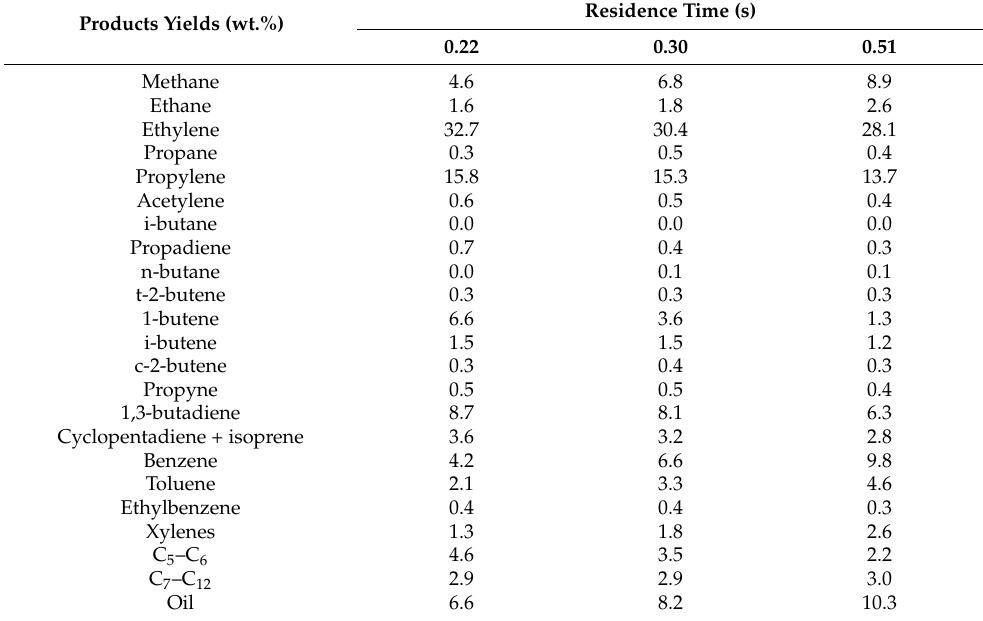
Table 4. Effect of residence time on the product yields for the steam cracking of a mixture of 10 wt.% FT residue and 90 wt.% HCVD at 815 ◦ C